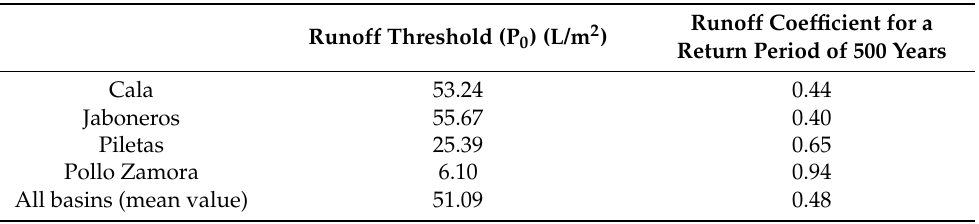
Table 2. Precipitation–runoff transformation data in the basins for a 500-year return period in 2010.